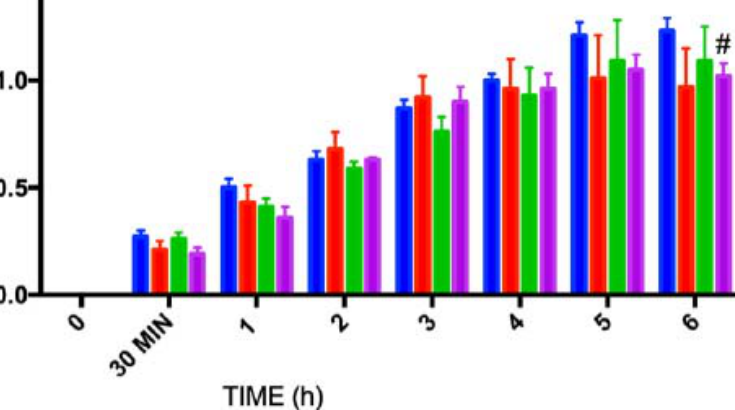
Figure 1. Preliminary data of acute e ff ects of cashew nuts at di ff erent doses on car-induced paw edema. Theanimalsweretreatedatdi ff erentdosesrespectively30, 60, and100mg / kg. Values = means ± standard error of the mean (SEM) of six animals in each group; # p < 0.05 vs. Carrageenan